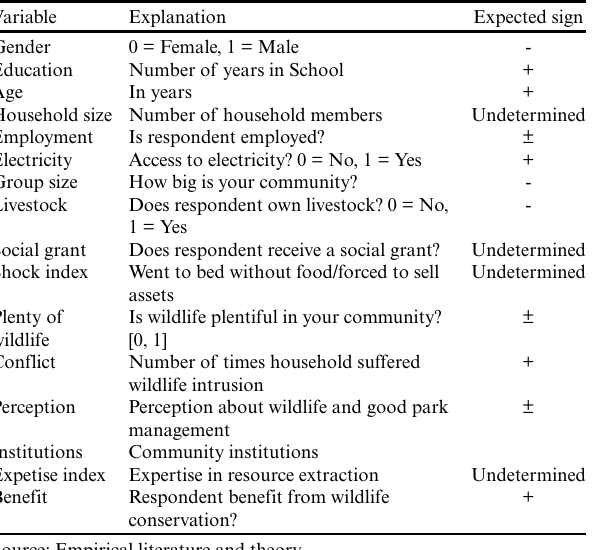
Table 3 . Explanatory variables and their